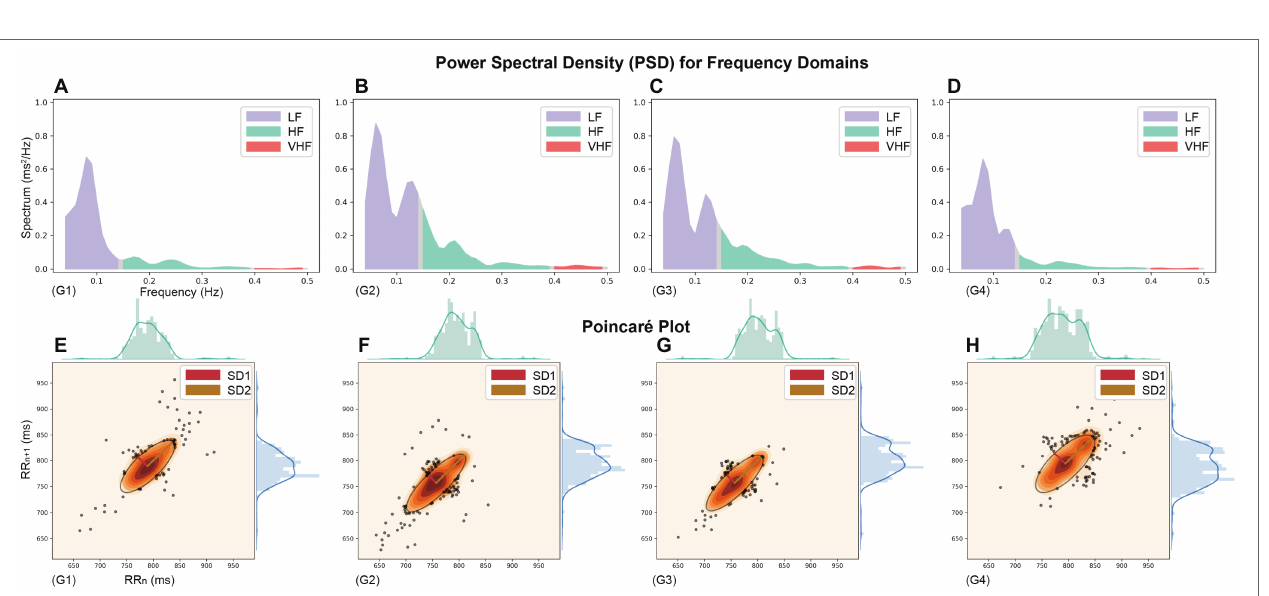
FIGURE 3 | The Power spectral density (PSD) and Poincaré plot throughout the simulated plateau experiment (Heart rate recording data from a randomly selected participant). (A–D) PSD for frequency domains and (E–H) Poincaré Plot Geometry during G1–G4 phases, the images are plotted on the same scale as the axes chosen to visualize the vertical